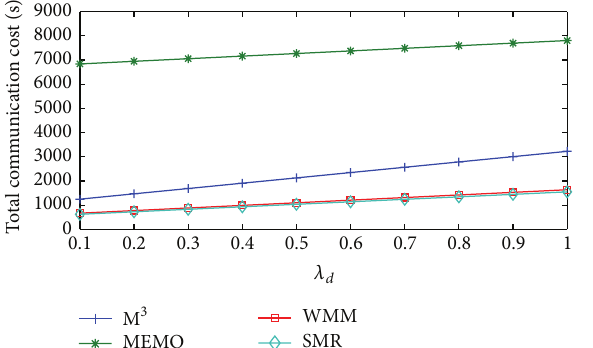
Figure 9: Total Communication cost/sec versus 𝜆 𝑑 .